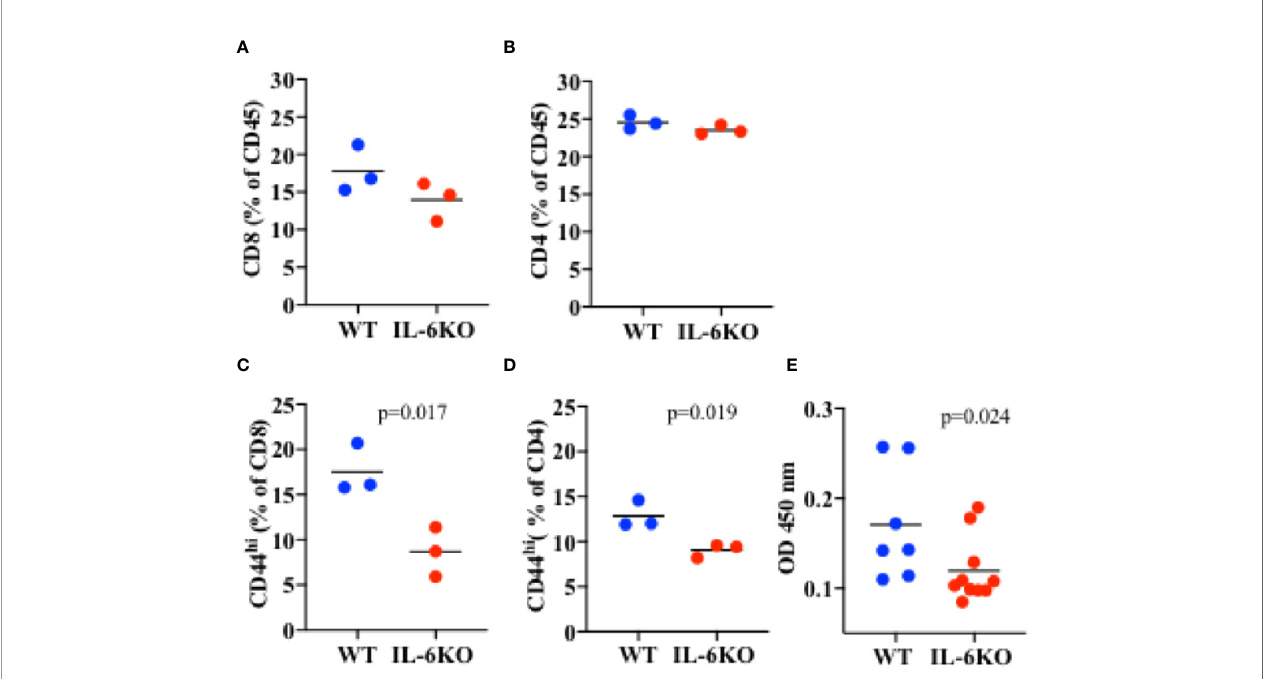
FIGURE 6 | Lower frequency of memory CD8 and CD4 cells in the lungs of i.n. immunized IL-6 KO mice. Mice (n = 3) received intranasal immunization with inactive virus on day 14 of life. Three weeks later, lungs were extracted and analyzed by fl ow cytometry. (A) Cells were gated for CD45 fi rst. % of CD8 cells within the CD45+ population is showed. (B) Cells were gated for CD45 fi rst. % of CD4 cells within the CD45+ population is showed. (C) Cells were gated for CD45 fi rst, and then for CD8 cells. % of CD44 high within CD8 cells is shown. (D) Cells were gated for CD45 fi rst, and then for CD4 cells. % of CD44 high within CD4 cells is shown. p value is determined by t test. (E) PR8-speci fi c IgG antibody titer in serum determined by ELISA. p value is calculated using the Mann-Whitney test, with signi fi cance set at p < 0.05. One experiment is